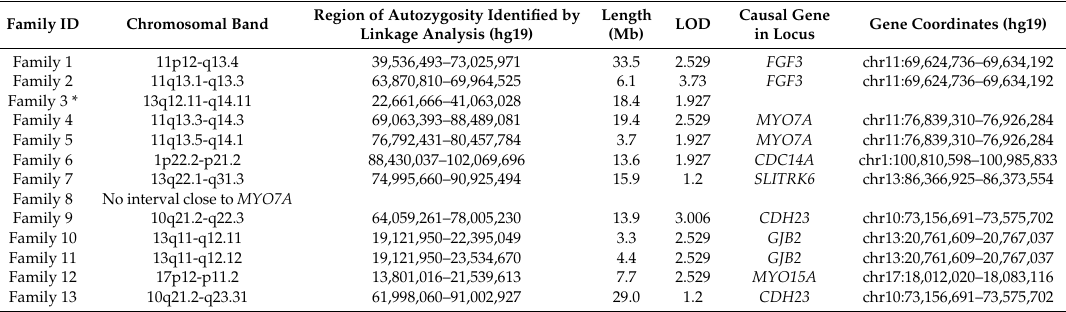
Table 3. Loci for autosomal recessive HL in 13 Pakistani families.